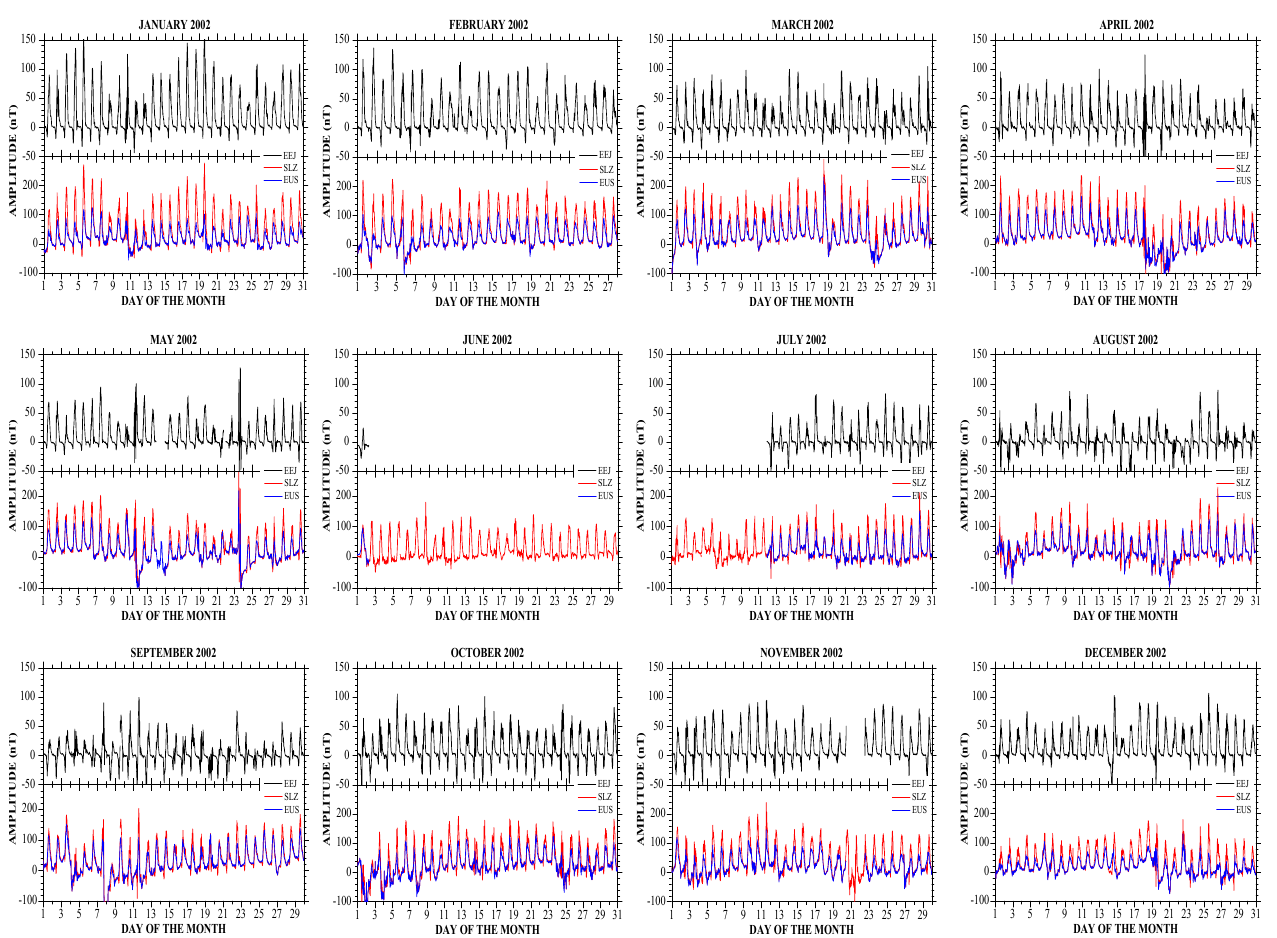
Figure 1. Diurnal variations of (top panel) the EEJ ground strength and (bottom panel) diurnal variations of the H component of the Earth magnetic field measured at (red) São Luís and (blue) Eusébio in 2002.